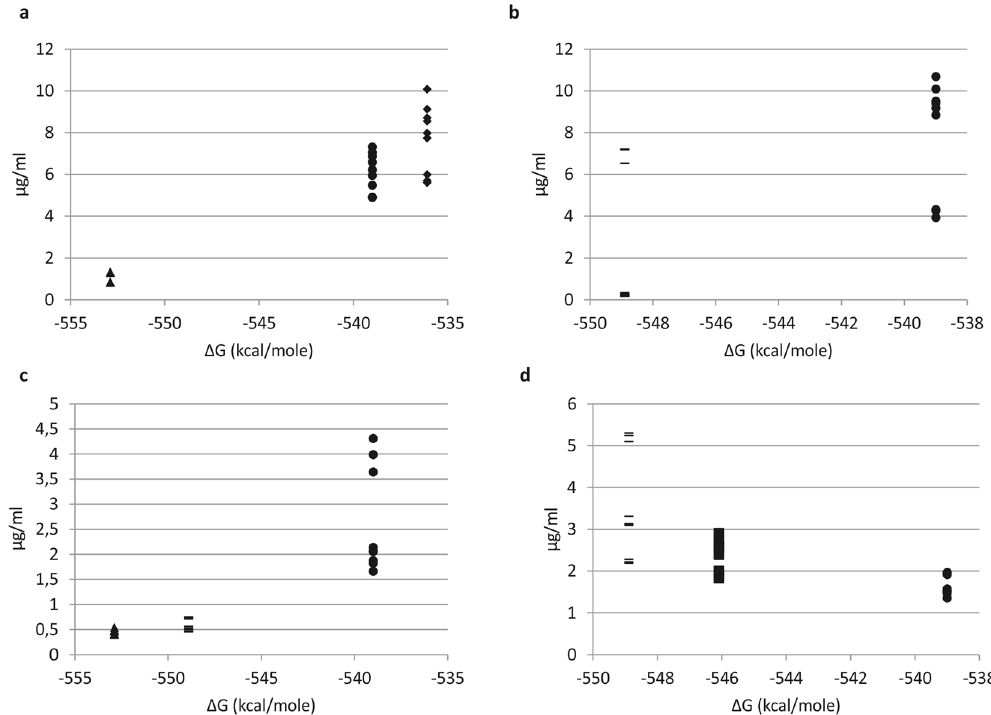
Figure 4. Correlation between mRNA minimum free energy ( Δ G) and protein yield. ( a ) BL21/pAK400 combination. ( b ) BL21/pLK04 combination. ( c ) XL1-Blue/pAK400 combination. ( d ) XL1-Blue/pLK04 combination. Data points are marked as follows: the parent Fab0 (sphere) and the variants 1 (diamond), 2 (line), 3 (triangle) and 4 (square).